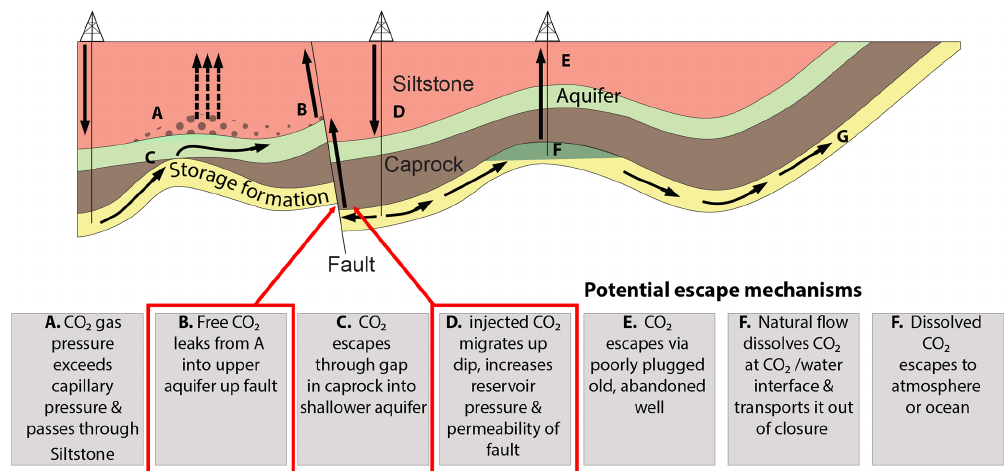
Figure 1. Potential leakage routes (modified after the IPCC special report, 2005). The scientific objective of the experiment is to better understand how prolonged exposure to CO 2 -rich water could affect the properties of a fault hosted in a caprock, altering its sealing properties (red